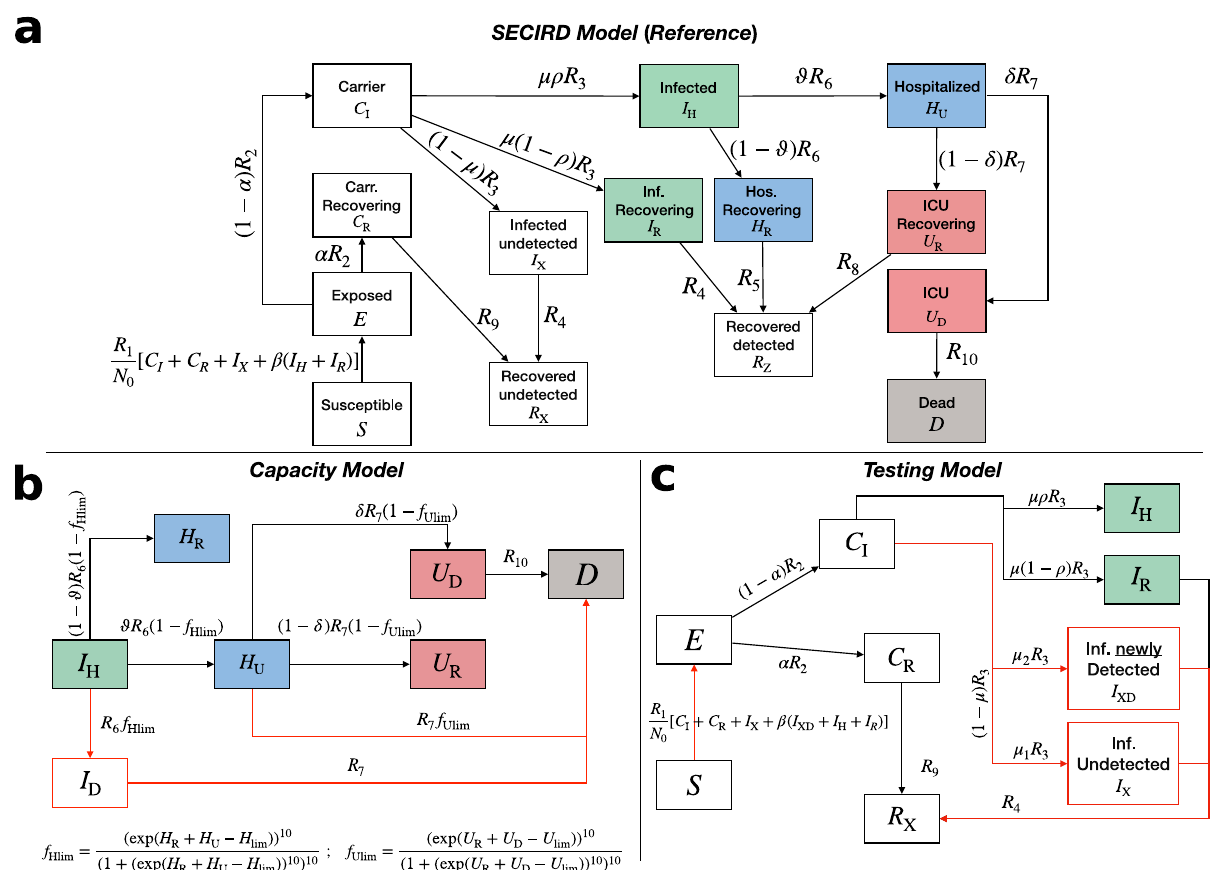
Fig. 1 Model schemes. a The Reference Model distinguishes healthy individuals with no immune memory of COVID-19 (susceptible, S ), infected individuals without symptoms but not yet infectious (exposed, E ), infected individuals without symptoms who are infectious (carrier, C R,I , asymptomatic and pre- symptomatic, respectively), infected ( I X,H,R ), hospitalized ( H U,R ) and Intensive Care Units (ICU) ( U D,R ) patients, dead ( D ) and recovered ( R X,Z ), who are assumed immune against reinfection. This scheme also applies to the Asymptomatic Model . b The Capacity Model is a modi fi ed branch of the Reference Model to investigate the impact of limited hospital and ICU access onto the death toll. f Hlim and f Ulim are steep exponential functions diverting the fl ux from I H and H U to D , respectively, when hospital and ICU occupancy reached their respective current capacities H lim ð t Þ and U lim ð t Þ . (c) The Testing Model is a modi fi ed branch of the Reference Model used to evaluate the impact of increasing case detection and isolation onto infection dynamics; I XD and I X describe newly detected and undetected cases, respectively. R x with x ∈ [2, … ,9] are per day transition rates between different states. Behavioral parameters ( ρ , ϑ , δ , R 1 and R 10 ) are subject to contingent factors, like Non-Pharmaceutical Interventions (NPIs), self-awareness, availability of hospital beds, etc., and, hence, are functions of